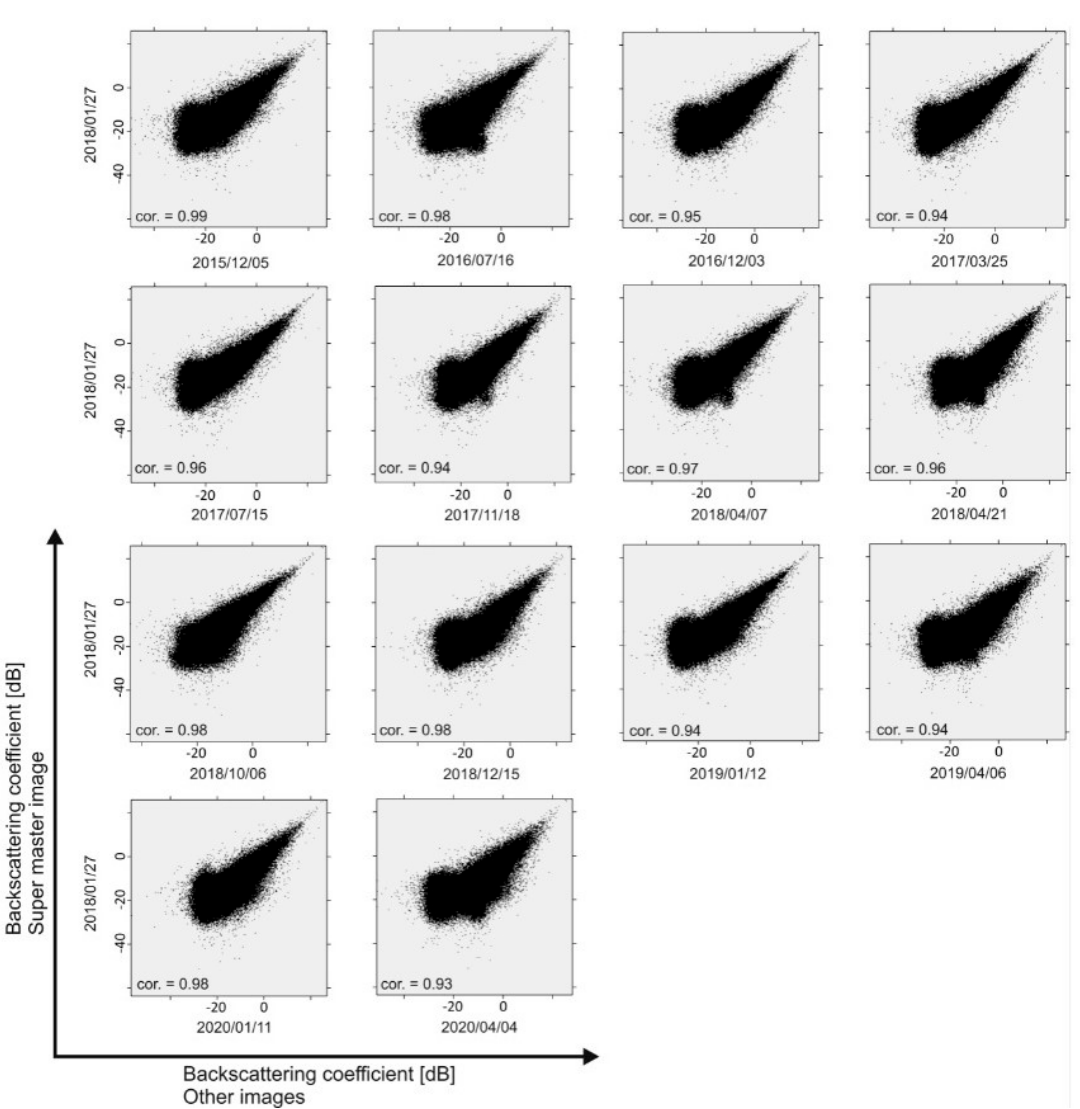
Figure 2. Scatter plots of backscattering coefficients of PALSAR-2 images with respect to super master image.